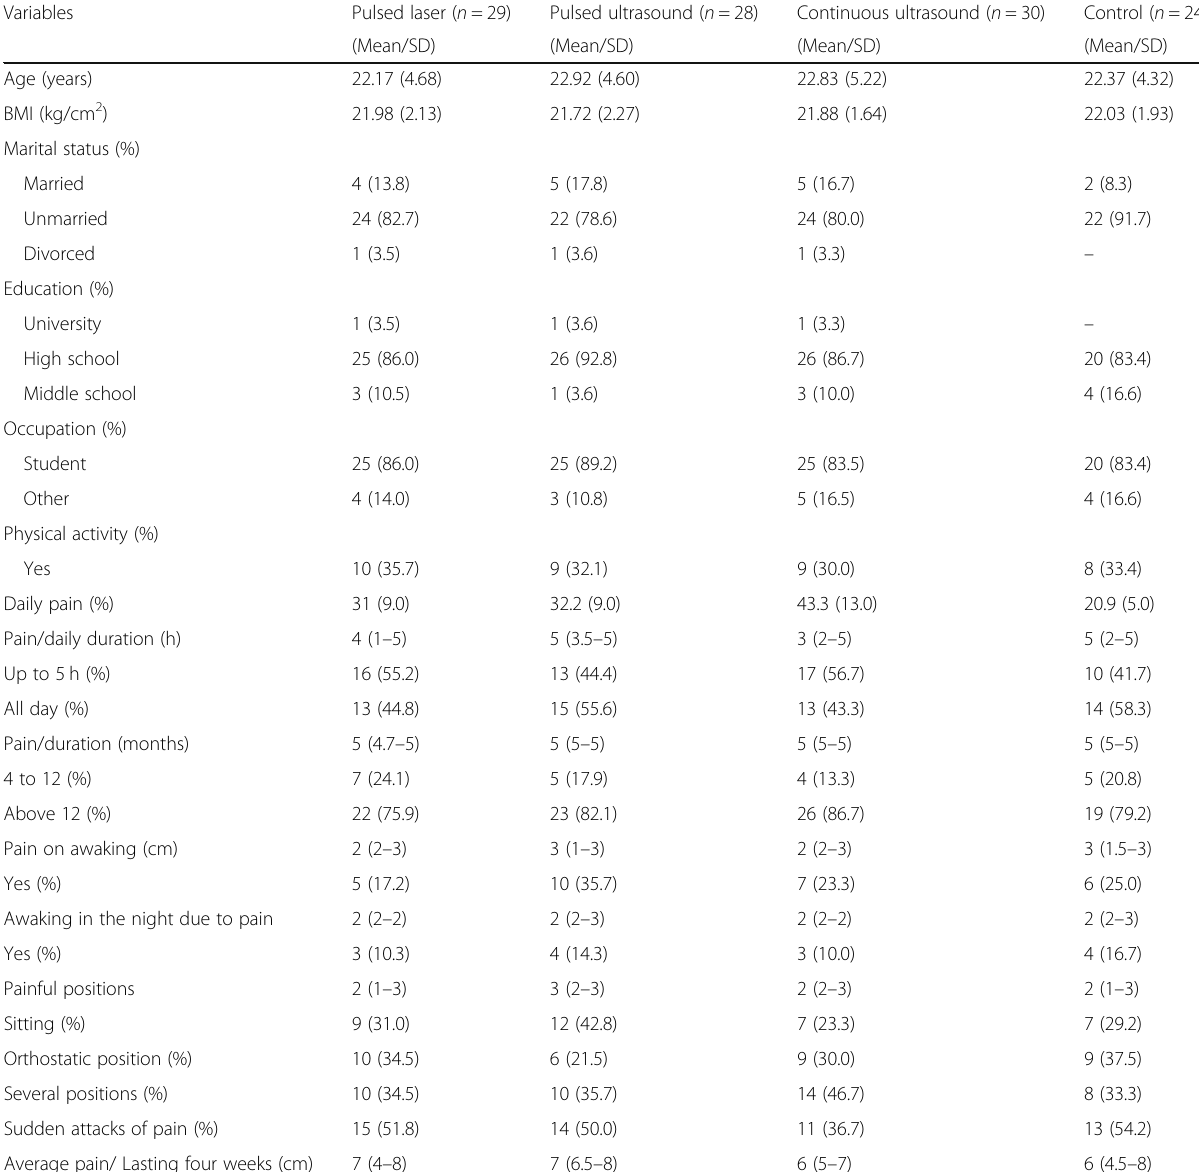
Table 1 Demographic characteristics of the groups at baseline Variables Pulsed laser ( n = 29) Pulsed ultrasound ( n = 28) Continuous ultrasound ( n =